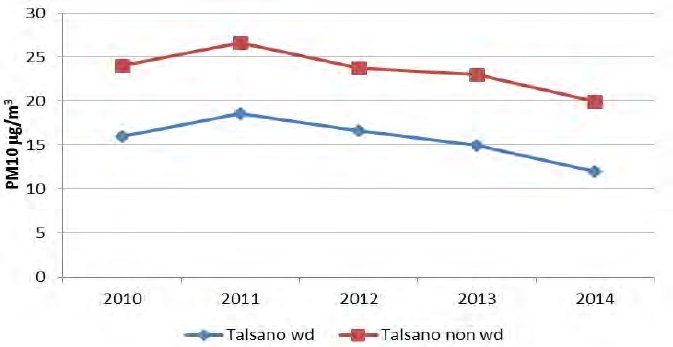
Fig. 7b: WD and nWD PM10 concentrations in Talsano